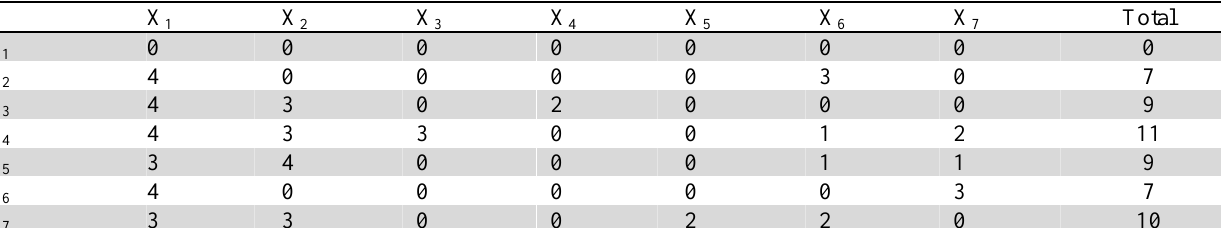
The relative effects of all 7 factors